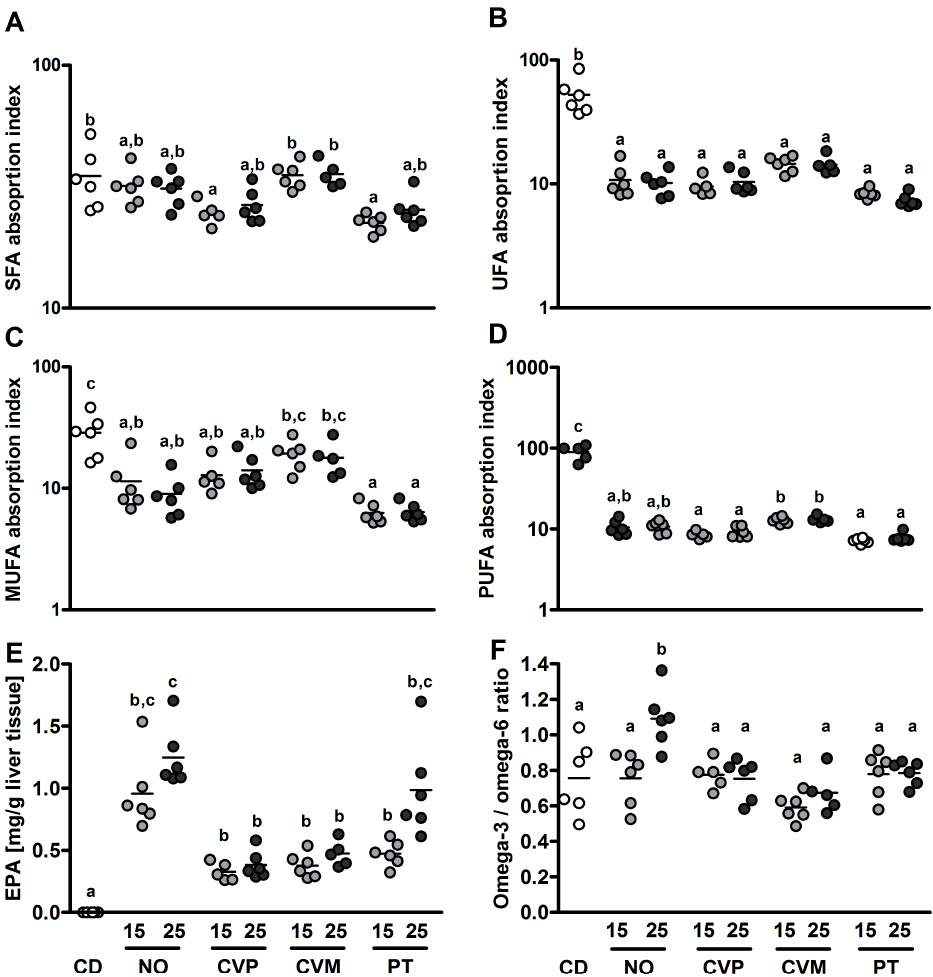
Figure 3. Apparent fatty acids absorption index of saturated (SFA, ( A )), unsaturated (UFA, ( B )), monounsaturated (MUFA, ( C )) and polyunsaturated fatty acids (PUFA, ( D )) and concentration of eicosapentaenoic acid (EPA, € ) in livers of female C57BL/6 mice after 14 days supplementation of microalgae in diet to 15 or 25% (wt %). The following microalgae were supplemented: N. oceanica (NO), C. vulgaris phototrophic cultured (CVP), C. vulgaris mixotrophic cultured (CVM), P. tricornutum (PT). The ratio omega-3/omega-6 ratio ( F ) was calculated. Data are expressed as means ± SEM ( n = 5–6). Different letters mark significant differences (ANOVA followed by Dunnett’s T3 ( B , D , E ) or Tukey’s post hoc test ( A , C , F ); p < 0.05). The apparent fatty acids absorption index of SFA shows increased indices for the control and CVM diets compared to CVP15 and PT15 diets. The UFA and PUFA absorption index is decreased for all microalgae diets (Figure 3B,D). The absorption of MUFAs after 14 days of microalgae supplementation is decreased in the PT, CVP and NO groups, while the CVM groups show no differences to the control diet (Figure 3C). The fact that soy oil contains no EPA is reflected in the amount of EPA in liver tissue (Figure 3E), which is significantly higher in the microalgae groups (means range between 0.3–1.3 mg/g liver tissue) compared to the control group (0 mg/g liver tissue). Additionally, it can be seen that EPA liver levels in the group fed the NO25 diet are significantly